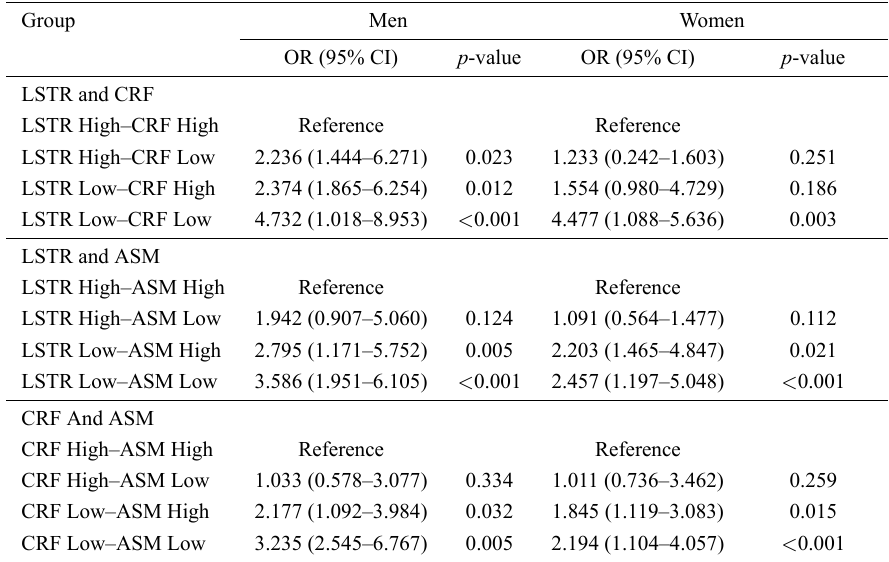
Table 5. The odds ratio for MetS based on two combined variables.